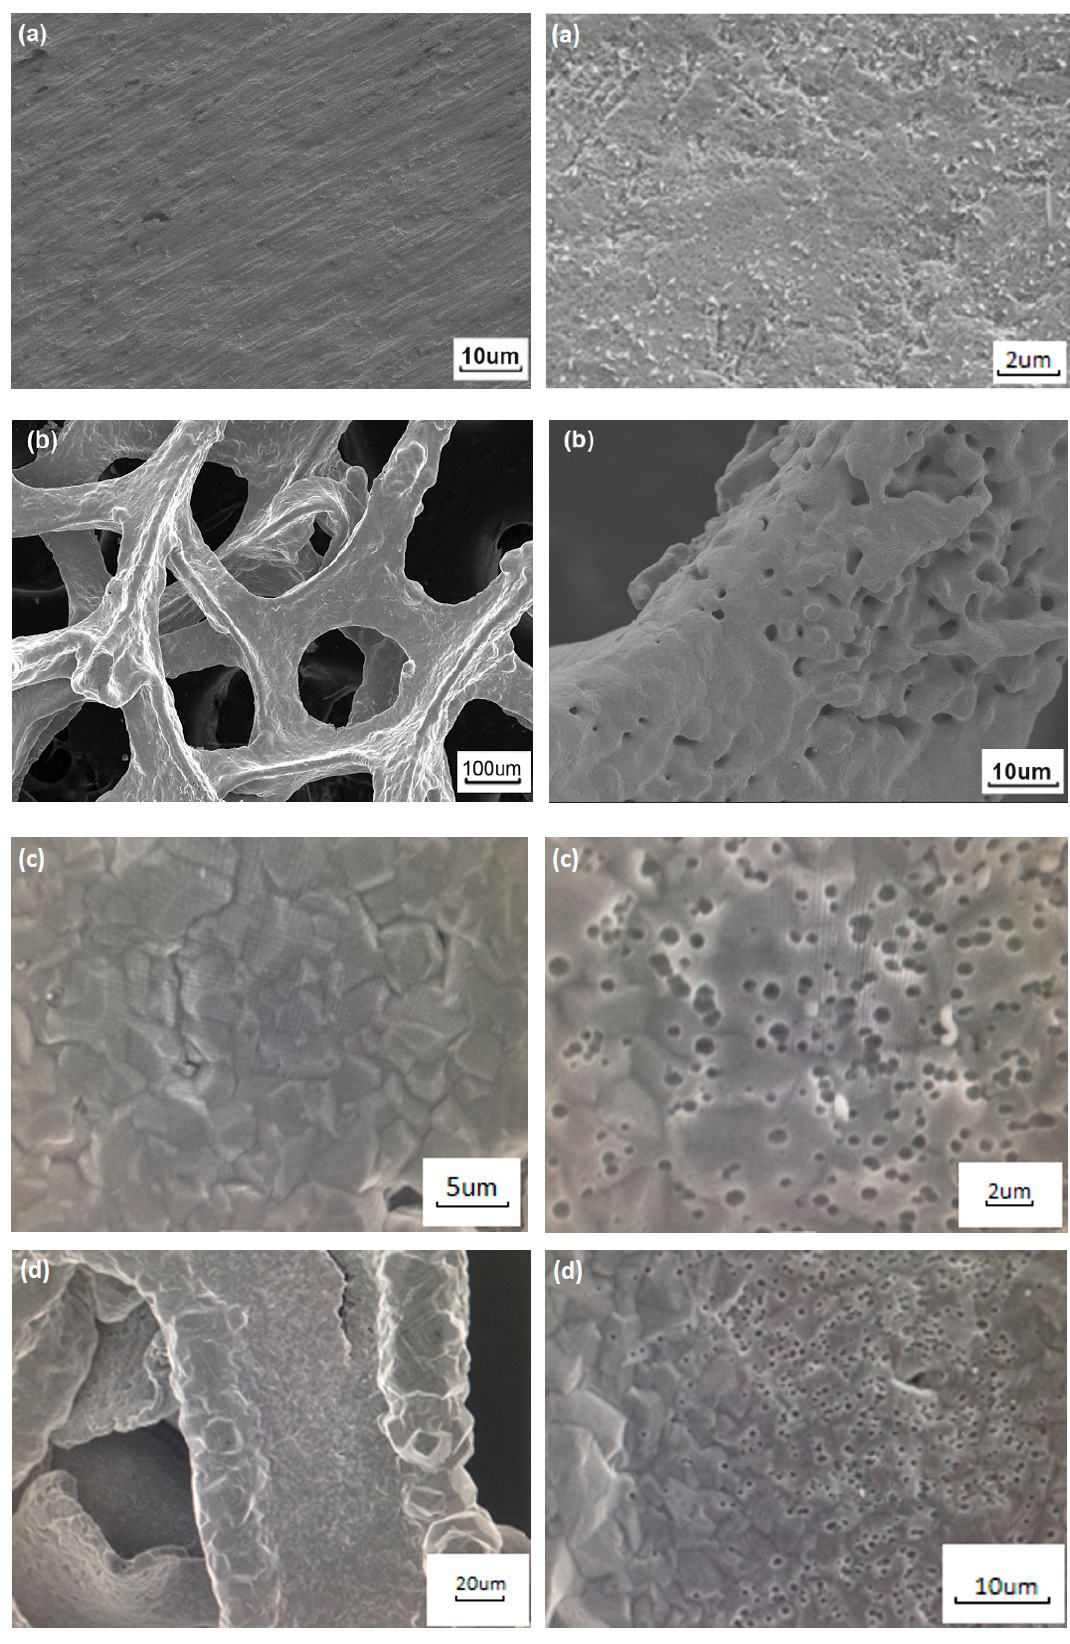
Figure 3. High resolution SEM images of the surface before ( left ) and after ( right ) ultrasonication of ( a ) copper foil, ( b ) copper foam, ( c ) aluminum foil, and ( d ) aluminum foam. 3.2. Electrochemical Performance of Lithium Ion Batteries with Different Nanoporous Metal Current Collectors Soft ‐ packed lithium ion batteries with a volume size of (3.5 ± 0.1 cm × 3.0 ± 0.1 cm × 0.2 ± 0.01 cm) were prepared and tested with a total of 16 different current collector matches. The word “nano” means the ultrasonically treated current collector. Table 2 presents the capacity density results for 16 batteries (in weight and in volume) with different current collector matches under a 0.5C rate. Figure 4 visualizes the results of Table 2 for clarification. It is concluded that the batteries can be classified into three different levels based on their capacity density. The first ‐ class batteries, with the highest capacity density of >350 mAh/cm 3 , have a current collector match of the aluminum foam cathode and the copper foam anode, independent of nanopore formation. The second ‐ class batteries, which have middle capacity density of between 250 and 300 mAh/cm 3 , are made of an aluminum foam cathode and copper foil anode, regardless of nanopore formation. Batteries with aluminum foil as the cathode, regardless of nanopore formation, belong to the third class, with the lowest capacity density, around 200 mAh/cm 3 . Two different electrode situations may affect the battery capacities. One is the existence of large micro ‐ sized pores on the metal foam sheet, which can hold more active electrode materials. The other is the different capacity densities between the graphite anode (about 320 mAh/g) and the NMC cathode (about 160 mAh/g). This difference indicates that an increase in the amount of the NMC cathode will have a greater effect on the whole battery’s capacity. Table 2. Capacity densities of lithium ion batteries with various current collectors. Battery